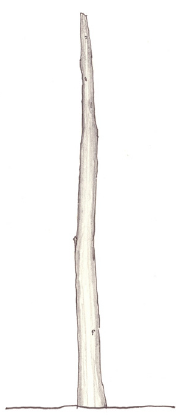
Figure 2. Drawing of a stick vertically placed on the ground ( barra de humo wood ). Source. Massimo Leserri, 2017 [4].